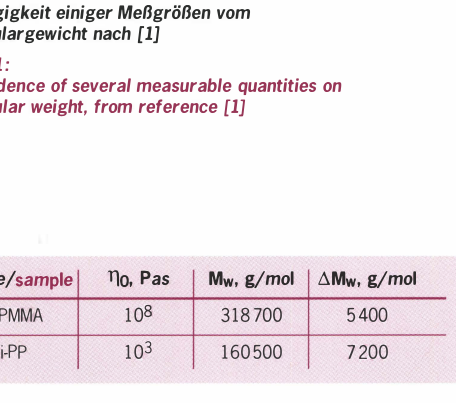
Table 2: Uncertainty, L'.Mw